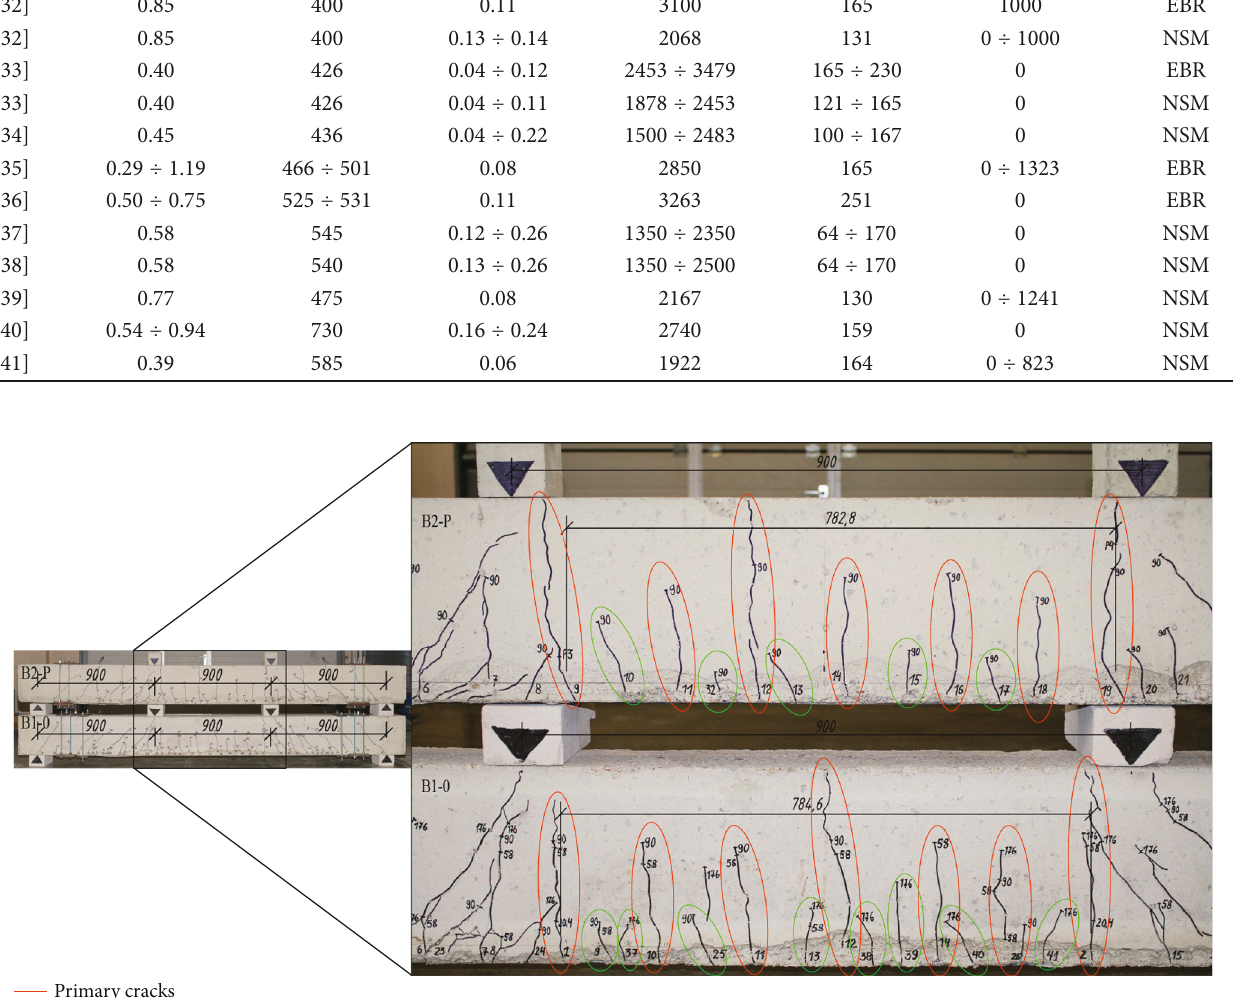
Figure 9: Experimental crack pattern of beams B1-0 and